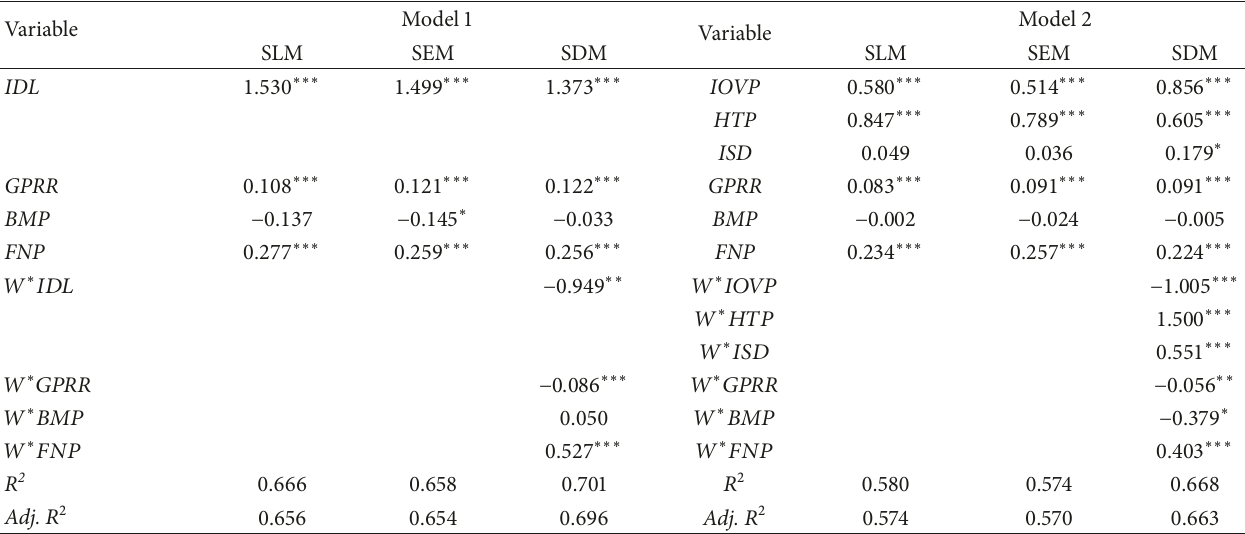
Table 4: Estimate results of time fixation effect space panel data